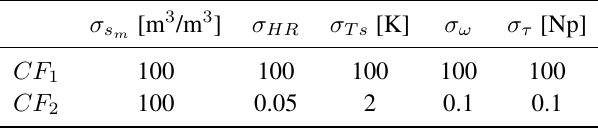
), soil roughness m and CF 1 2